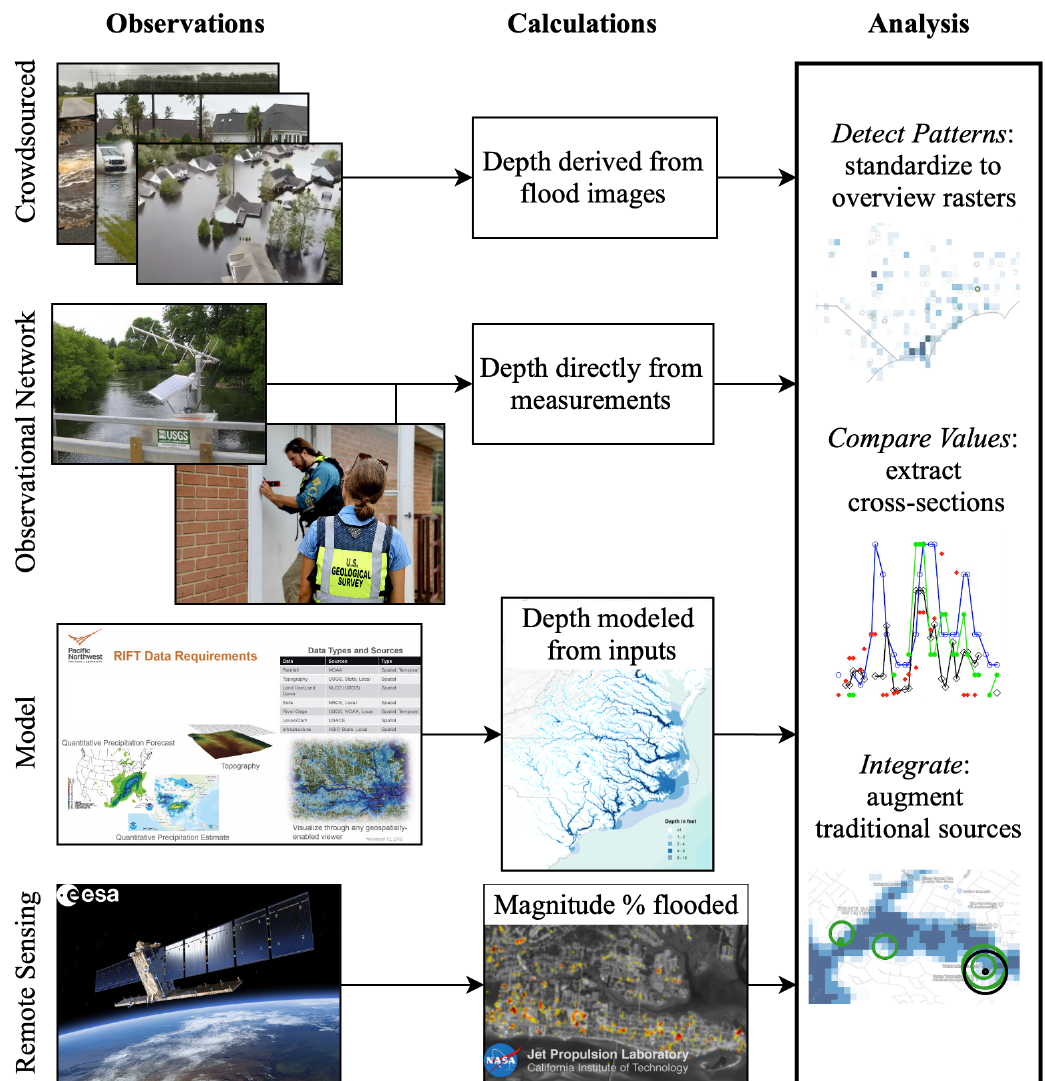
Figure 6. This flowchart provides an overview of the conceptual framing and methodological approach of the